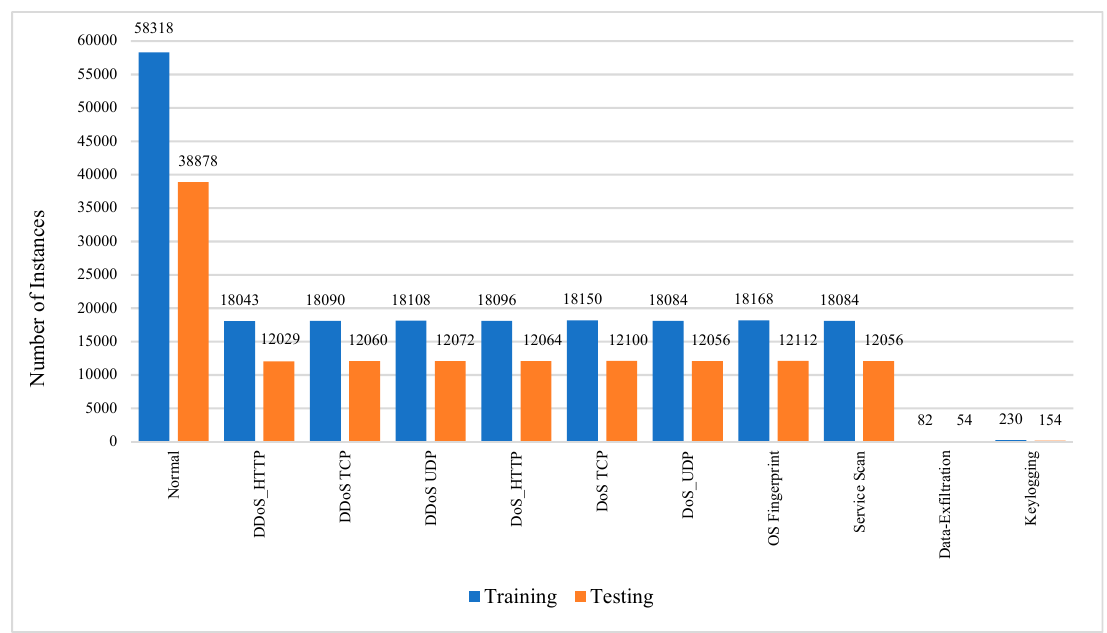
Figure 5. IoT Botnet Dataset Training and Testing Distribution.